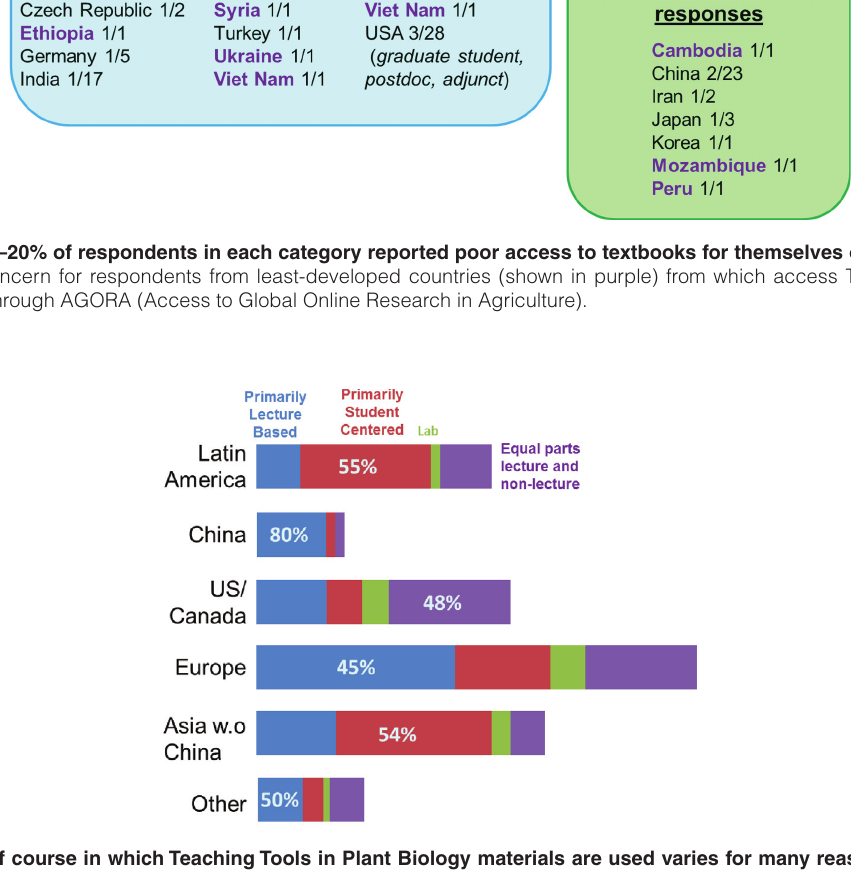
Figure 3. The type of course in which Teaching Tools in Plant Biology materials are used varies for many reasons and depends on institutional, political and cultural practices as well as instructor preferences. This question was only asked to instructors, who selected one category out of the four options